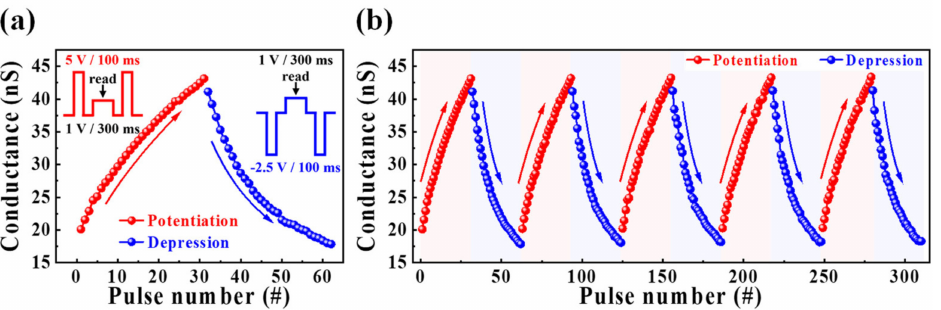
Figure 7. ( a ) Potentiation and depression characteristics of synaptic weights by applying pre-synapse pulses. ( b ) Endurance properties for five cycles of potentiation and